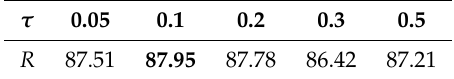
Table 2. Influence of transition width τ for texture segmentation (best score in bold).